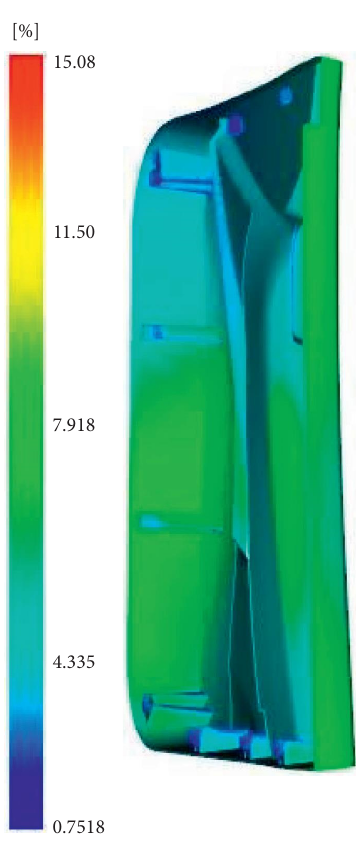
Figure 17: Volume shrinkage diagram.